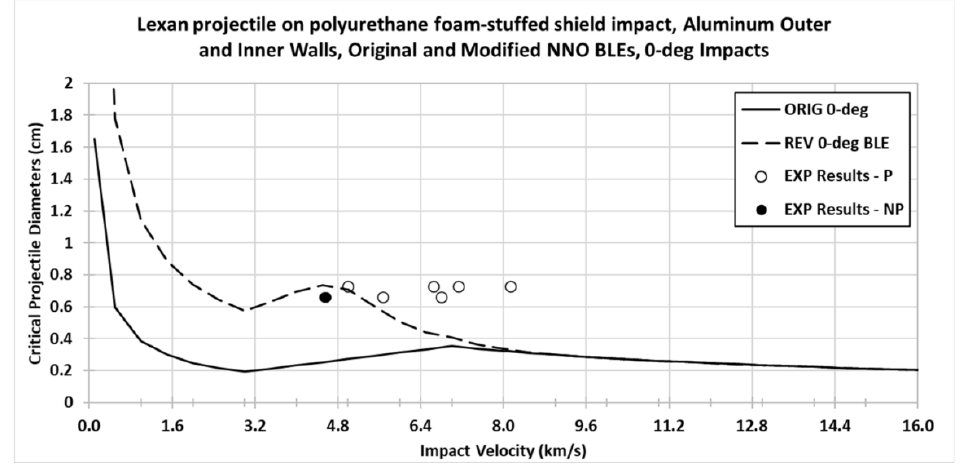
Figure 4. Comparison of Original and Modified NNO BLEs against P/NP data in [6] for Dual-Wall Systems with Aluminum Outer and Inner Walls.